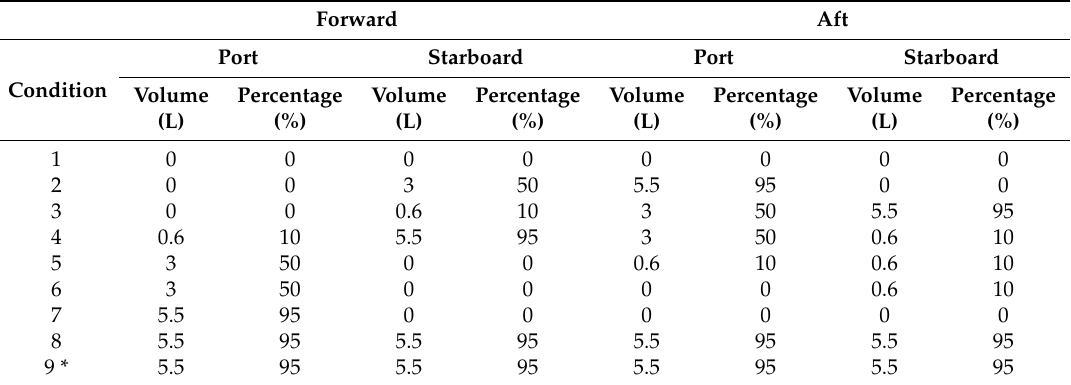
Table 3. Water Tank Loading Conditions.